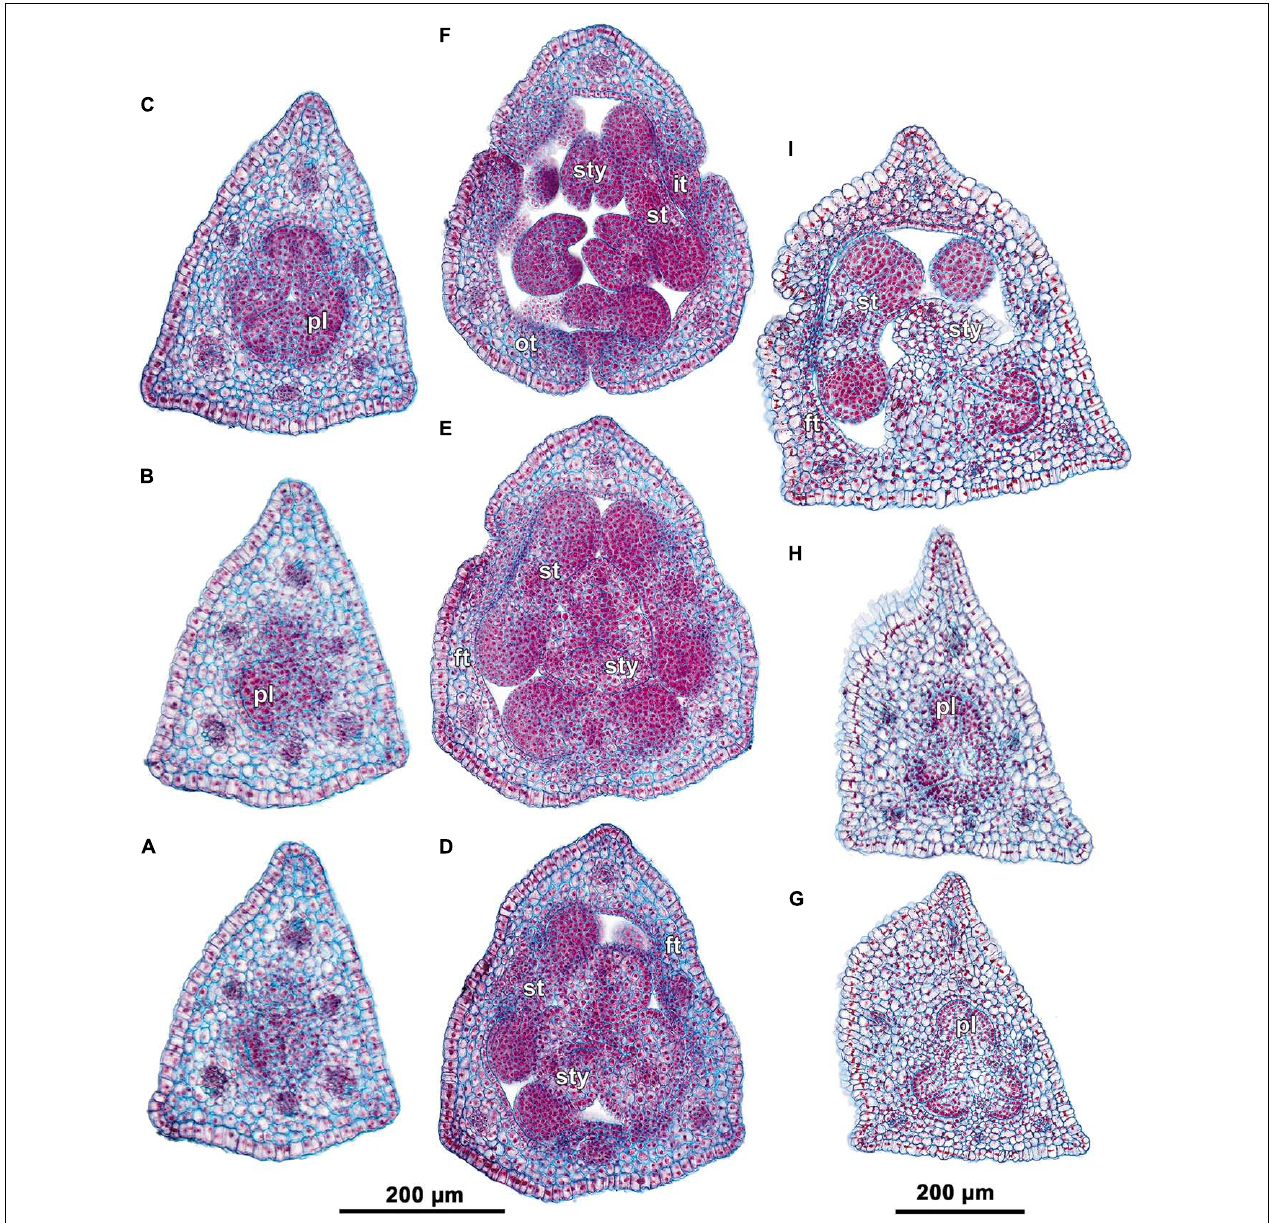
FIGURE 8 | Transverse microtome sections of underdeveloped flowers of Burmannia (LM). (A–F) B. lutescens ( Nuraliev, Lyskov NUR 3120 ). (A) Ovary base. (B) Synascidiate zone of ovary. (C) Symplicate zone of ovary. (D,E) Flower at level of anthers and common style (style fusion not yet completed). (F) Flower at level